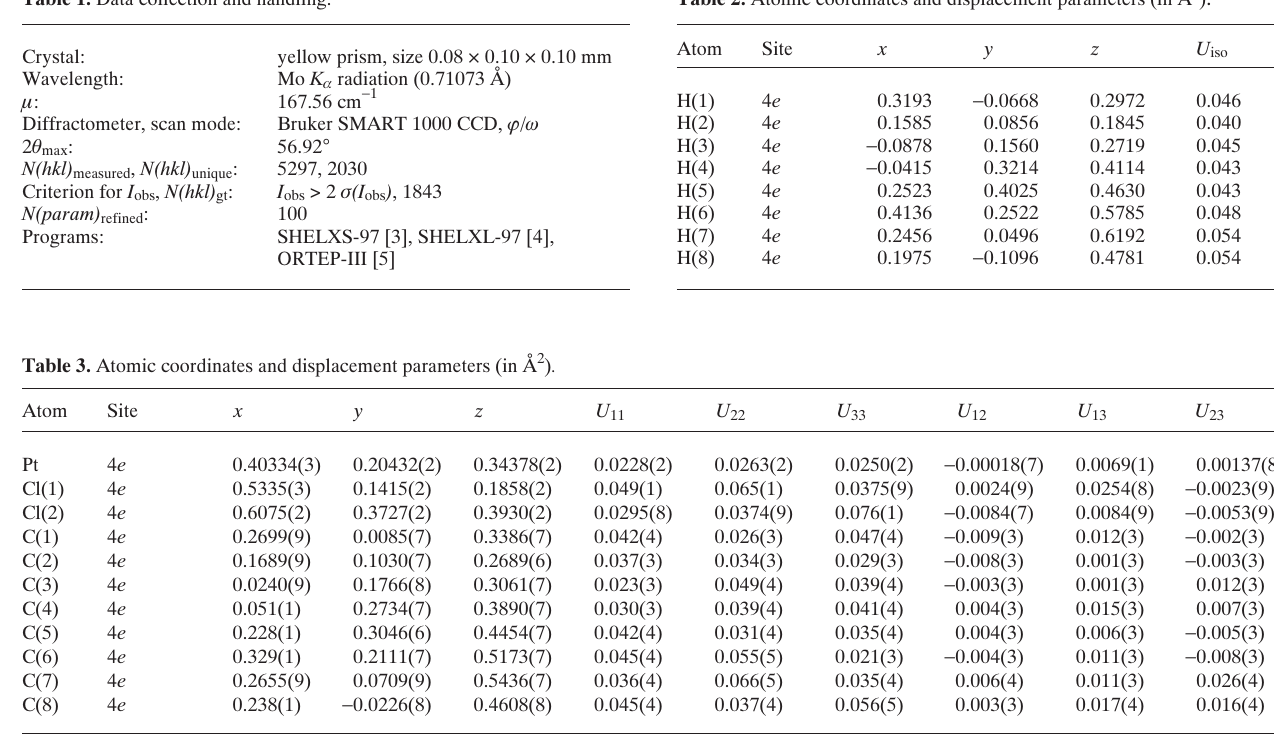
Table 2. Atomic coordinates and displacement parameters (in Å 2 ) . Table 1. Data collection and handling.